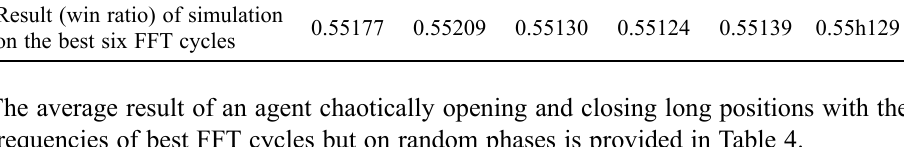
Table 4. Results of a chaotic agent